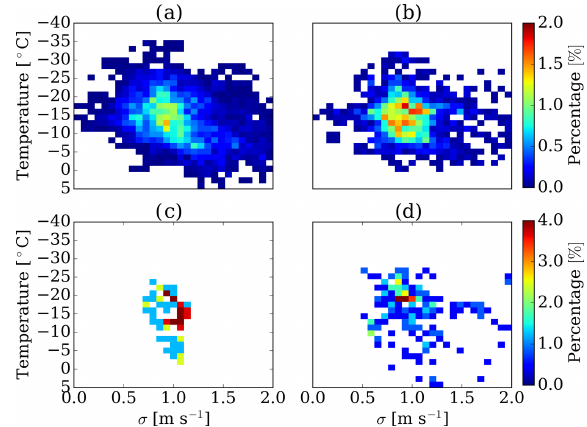
Figure D3. Same as Fig. D1, but for σ